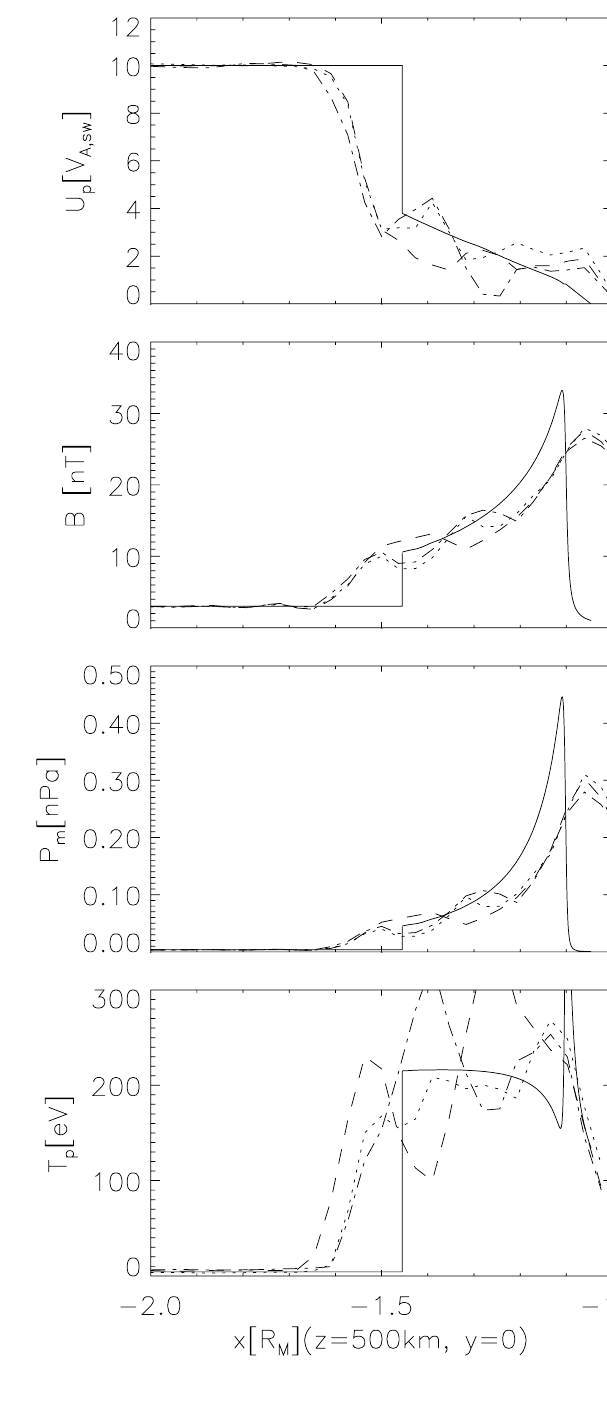
Fig. 3b. Comparison of MHD and hybrid magnetosheath profiles along the x direction for z =500km, y =0. stand-off distances was found to be ∼ 1 . 7 R M (Vignes et